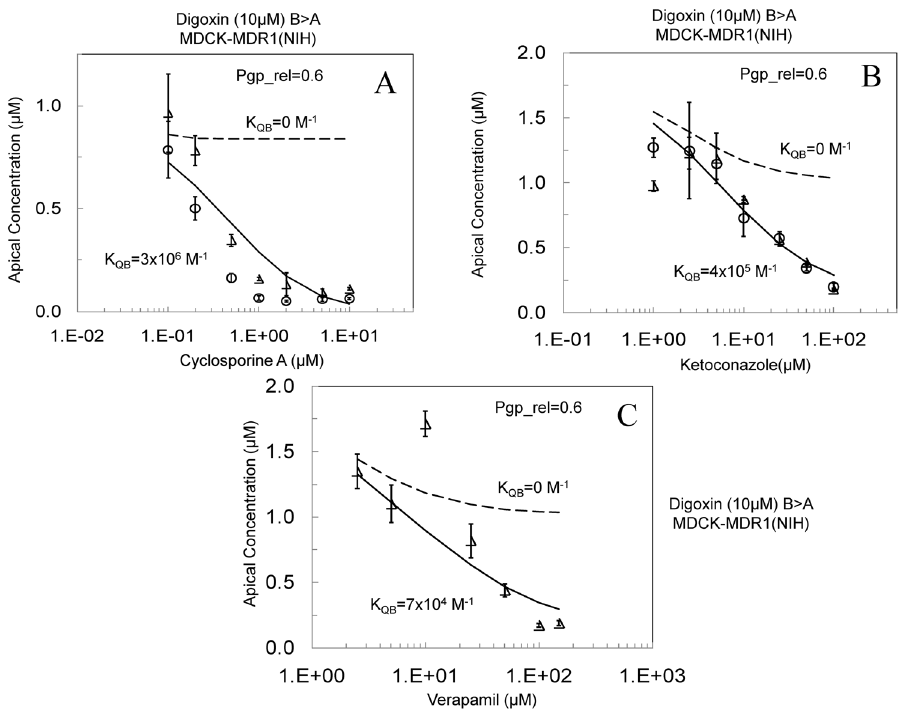
Figure 6. Inhibition of 10 m M digoxin B . A transport across the MDCK-MDR1-NIH cell monolayers, as measured on the apical side after 1 hr with increasing concentrations of cyclosporine A (Fig. 6A), ketoconazole (Fig. 6B) and verapamil (Fig. 6C), data acquired at Absorption Systems. Open symbols represent experimental data sets. The dotted lines shows the fitted inhibition assuming that the inhibitor binds only to P-gp, i.e. K QB =0. The solid lines show the fit using the values of K QB shown in Table 3.